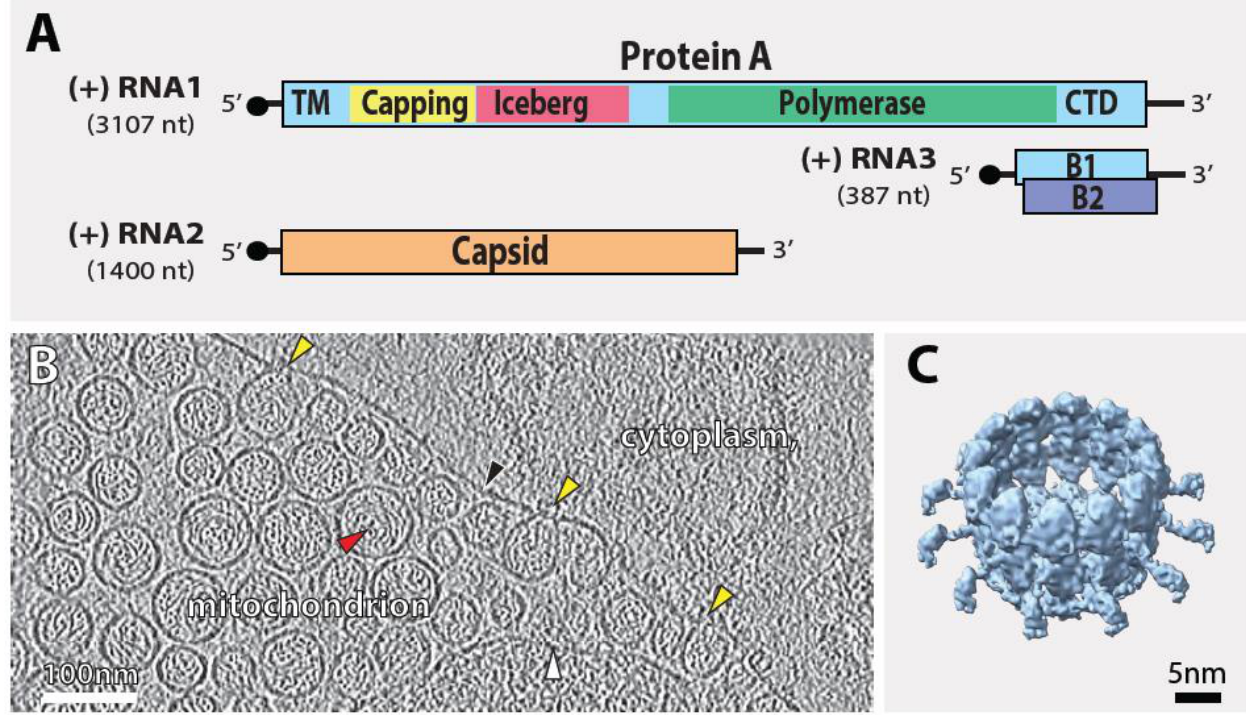
Figure 1. Nodavirus genome organization and replication. ( A ) The bipartite FHV RNA genome encodes the viral replicase protein A, the key protein for viral RNA replication, on RNA1 and the capsid protein precursor on RNA2. Subgenomic RNA3, transcribed from RNA1, encodes protein B1, identical to the C-terminus of protein A, and protein B2 which is an RNAi suppressor. ( B ) Cryo-EM tomogram of Drosophila S2 cells with nodavirus replication complexes: invaginations (spherules) of the outer mitochondrial membrane into a vastly dilated intermembrane space. Arrowheads: black = outer mitochondrial membrane; white = inner mitochondrial membrane; red = spherules, filled with dsRNA; yellow = crown-like structures at the spherule open necked connections to the cytoplasm. ( C ) Tomographic reconstruction of the 12-fold symmetrical nodavirus replication complex crown, from reference [24].